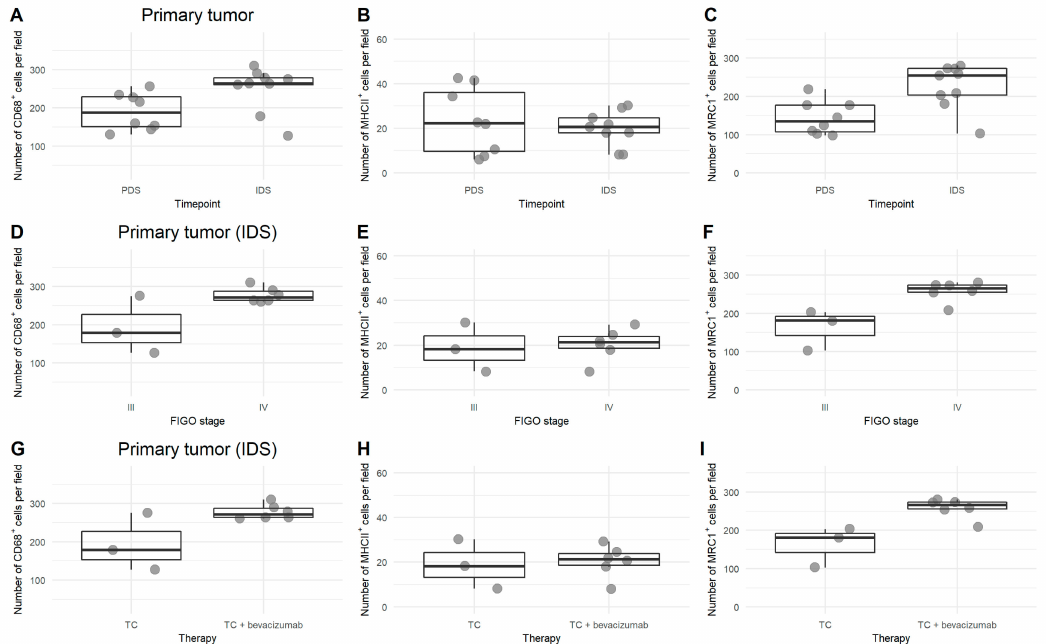
Figure 4. Comparison of macrophage profile after platin-based chemotherapy and bevacizumab in HGSOC. ( A – C ) Number of CD68 + ( A ), MHCII + ( B ), and MRC1 + ( C ) cells per field in primary